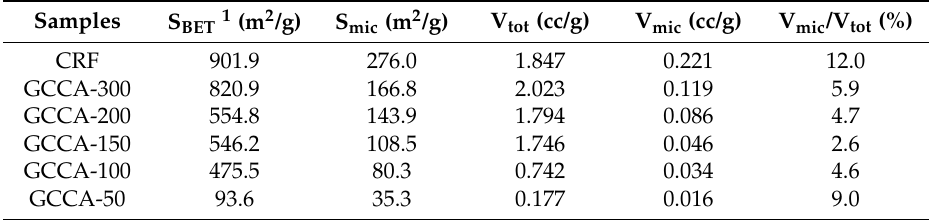
Figure 4. ( a ) N 2 adsorption–desorption isotherms at 77 K and ( b ) pore size distribution of CRF and different GCCAs. Table 1. Pore structure parameters of CRF and GCCAs obtained from N 2 adsorption measurement (CRF: pure carbon aerogel derived from the polycondensation of R and F; GCCAs: graphene– carbon composite carbon aerogels).